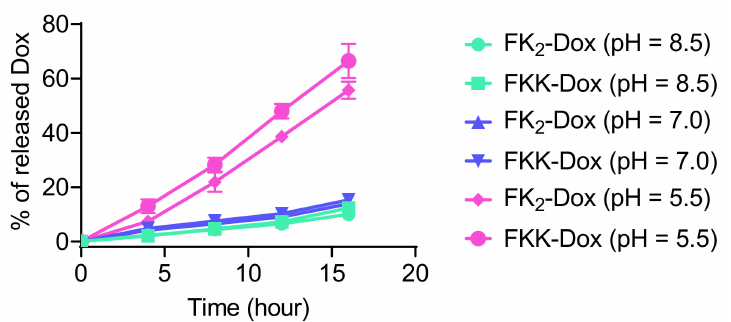
Figure 4. The in vitro Dox release kinetics from (FK) 2 -Dox and FKK-Dox assembled nanoparticles at pH = 8.5, 7.0, or 5.5. The values were obtained from three independent experiments. Error bars are standard deviation